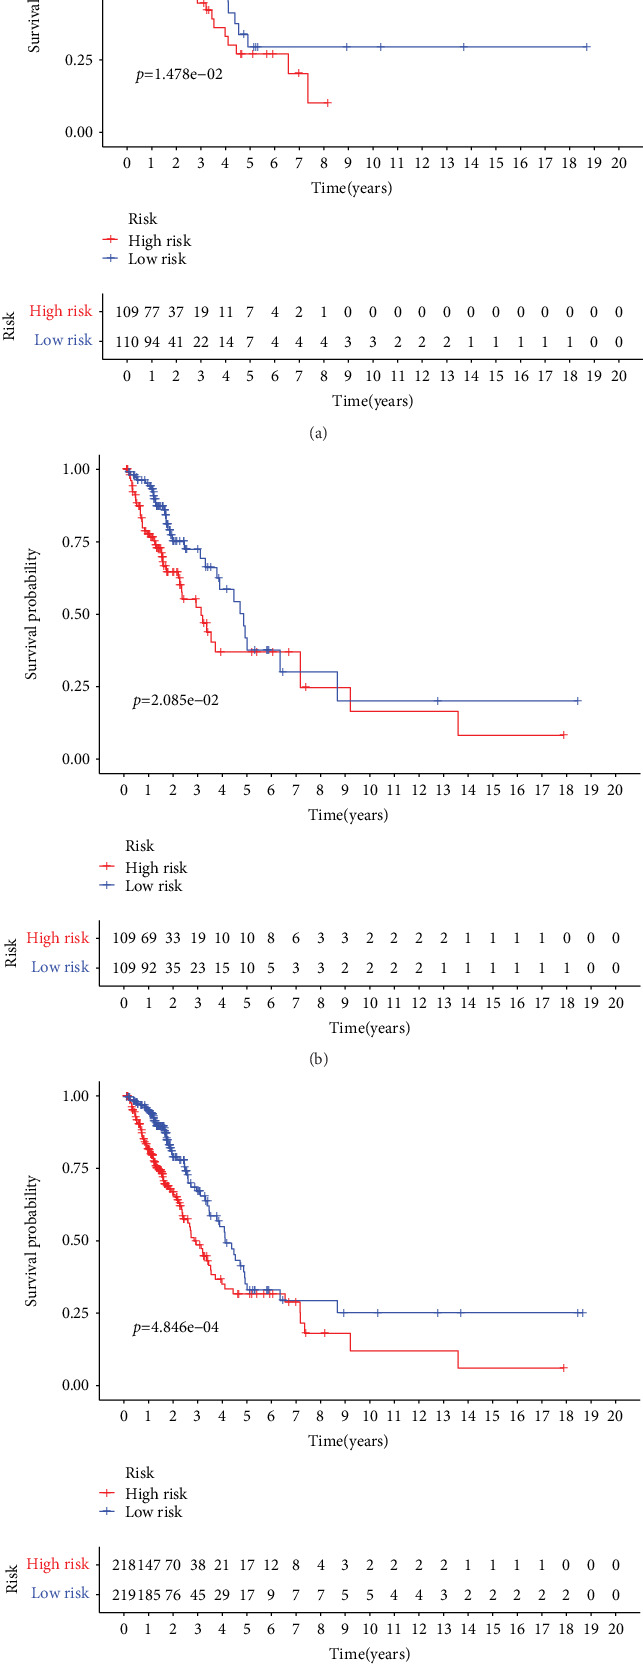
Kaplan–Meier curves of the risk signature in three sets. (a) Training set. (b) Validation set. (c) Combination set.